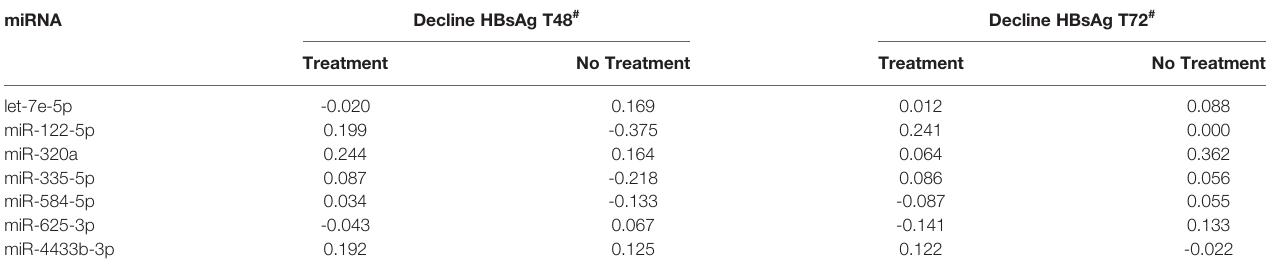
TABLE 5 | The association between baseline plasma miRNAs levels and HBV-DNA decline after 48 and 72 weeks in treated and non-treated CHB. miRNA Decline HBsAg T48 # Decline HBsAg T72 # Treatment No Treatment Treatment let-7e-5p